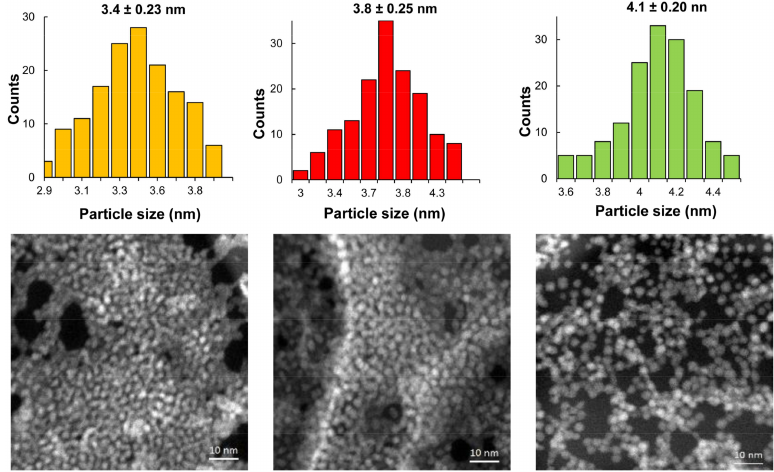
Figure 2. Scanning transmission electron microscopy (STEM) images obtained by Z contrast of the MPA-capped QDs at different molar ratios of Te:Se (1:0, 0.75:0.25, 0.50:0.50) and time reaction of 60 min. Above: the corresponding histogram of size